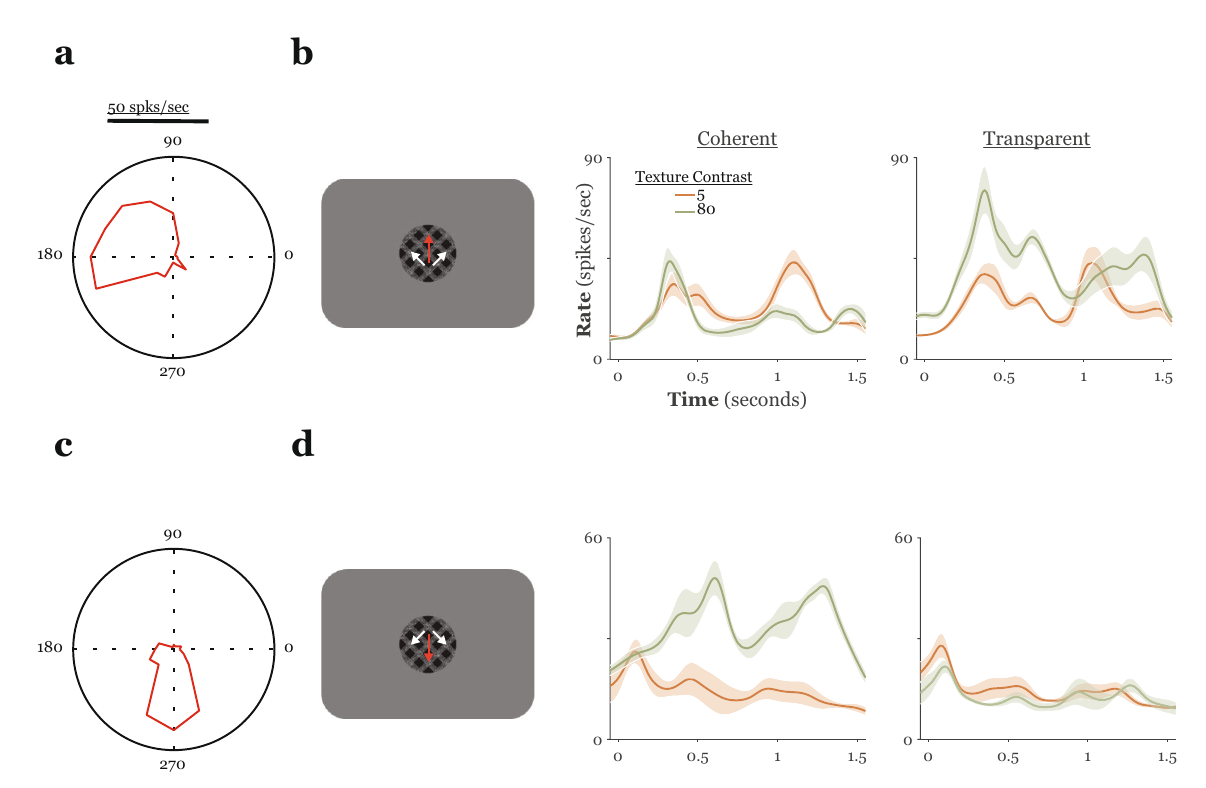
Fig. 3 | Representative MT single-unit responses to textured plaid stimuli. a Polarplot of the direction tuning pro fi le in response to a singlesine grating for a representative MT unit from monkey S. The angle represents direction of grating motionandmagnituderepresents fi ringrate,thisunit ’ spreferreddirectionroughly overlapped one of the component directions in plaids with a pattern direction of 90°(up). b Peri-stimulustimehistograms(PSTHs)inresponsetoplaidsdriftingina pattern direction of 90° (shown schematically on the left) for the unit shown in a . Responses are sorted according to the type (coherent/transparent – middle/right panels, respectively) and Michelson contrast (color cued across PSTHs) of the